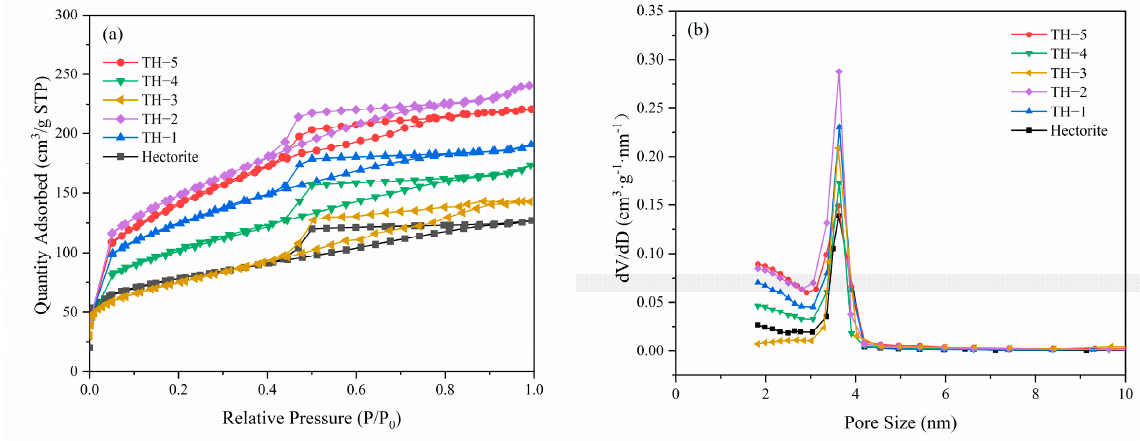
Figure 5. N 2 adsorption-desorption isotherms and pore size distribution: ( a ) isotherms and ( b ) pore size. The pore structure parameters including specific surface area (S BET ), pore volume, pore size, and crystal size are summarized in Table 1. Compared with hectorite, the surface